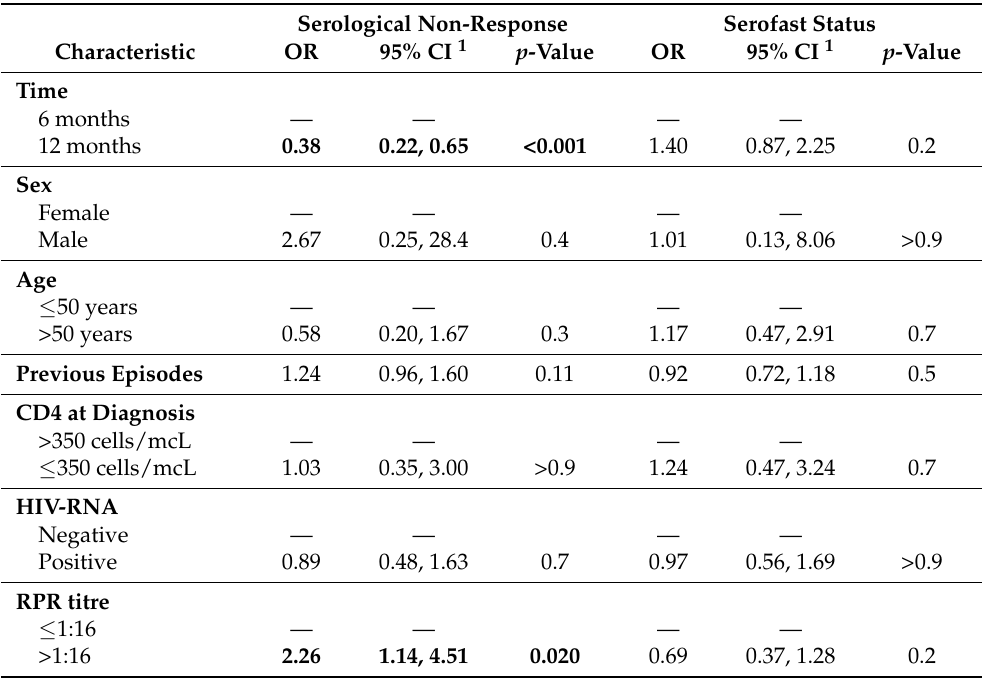
Table 5. Risk factors associated with a serological non-response and a serofast status in syphilis reinfection among people living with